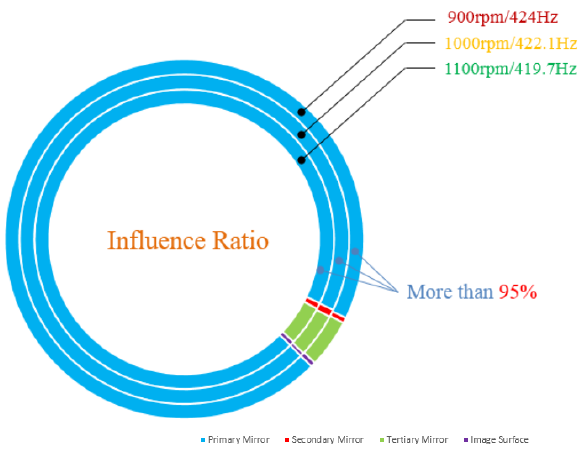
Figure 8. Influence ratio of each optical component.